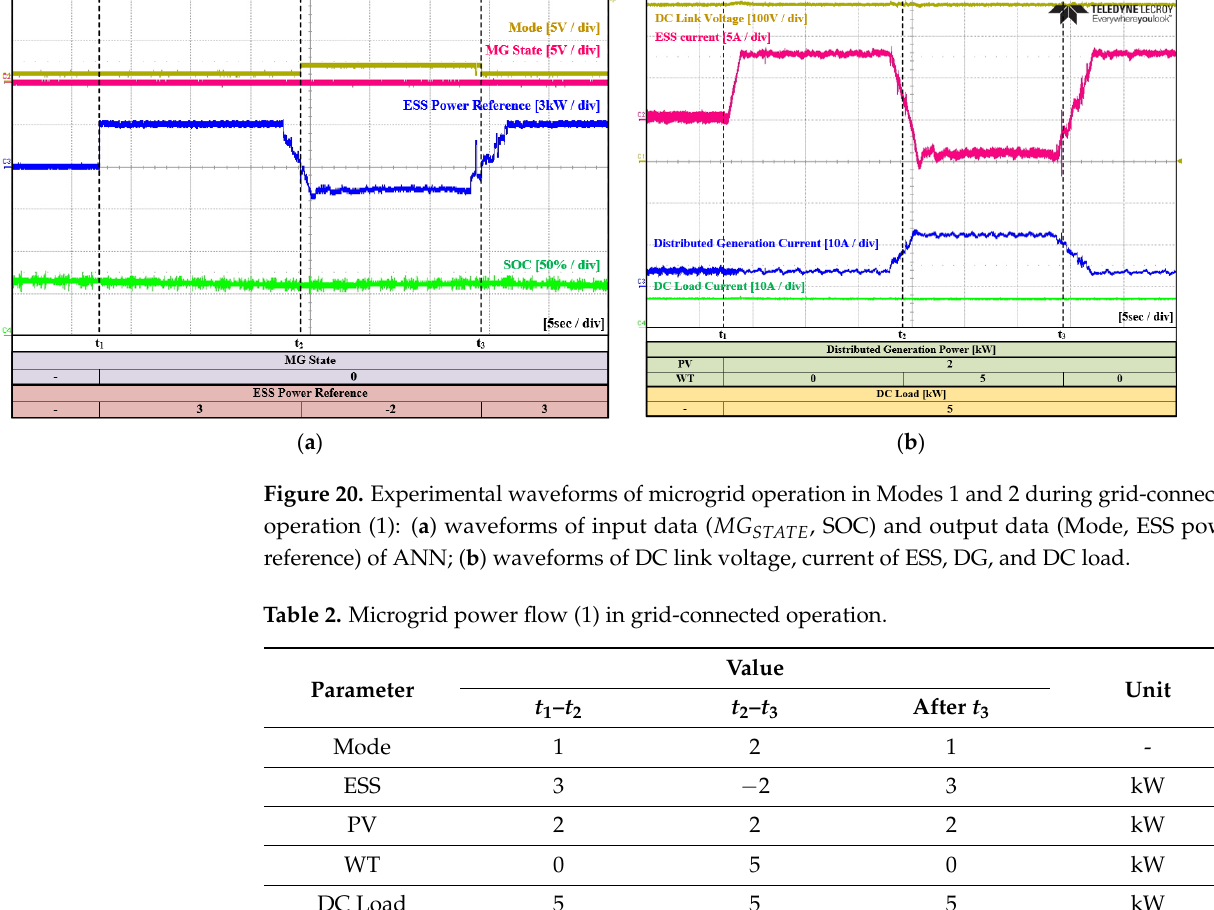
Table 2. Microgrid power flow (1) in grid-connected operation.